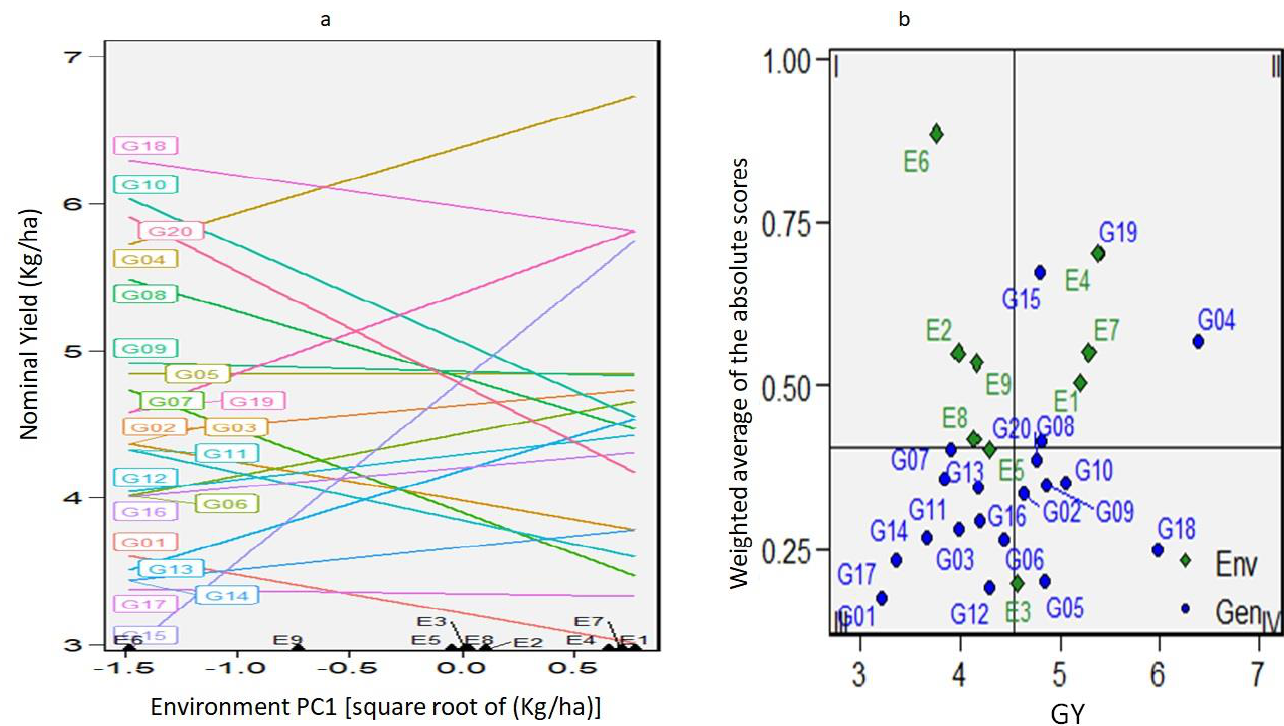
Figure 5. Biplot interpretation for understanding the genotype × environment interaction for the 20 wheat genotypes. ( a ) Nominal GY for the genotypes as a function of the environment scores of the IPCA1 and ( b ) biplot of the GY vs. the weighted average of absolute scores for the best linear unbiased predictions of the genotypes vs. the environment interaction (WAASB).